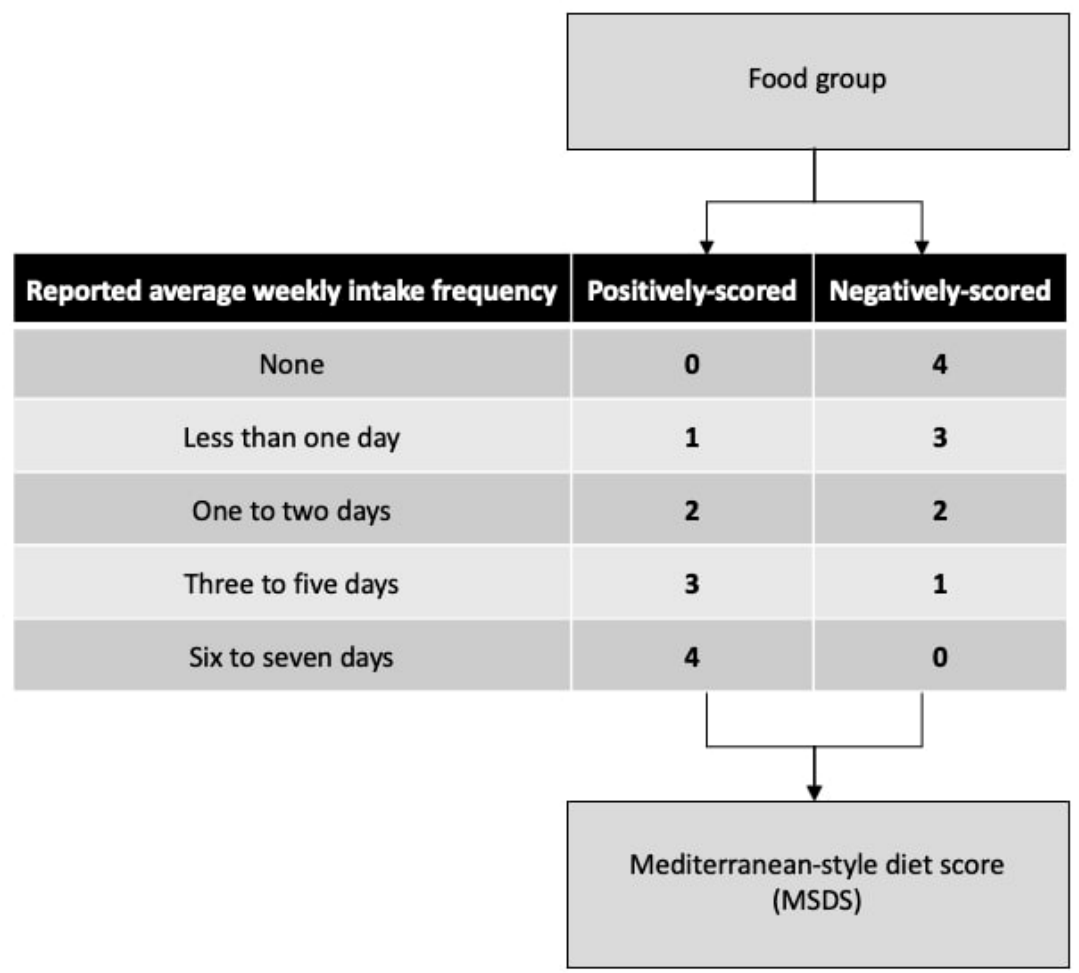
Figure 1. A flow chart of the scoring system used to derive the Mediterranean-style diet score. Each of the food groups was either positively or negatively scored based on the mother’s report of her average weekly intake frequencies during pregnancy. All foods were positively scored except meat, which was negatively scored.